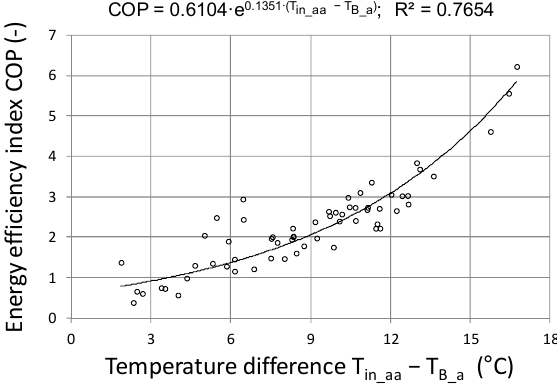
Figure 27. Energy efficiency of heat storage depending on the temperature difference. Figure 27. Energy e ffi ciency of heat storage depending on the temperature di ff erence.